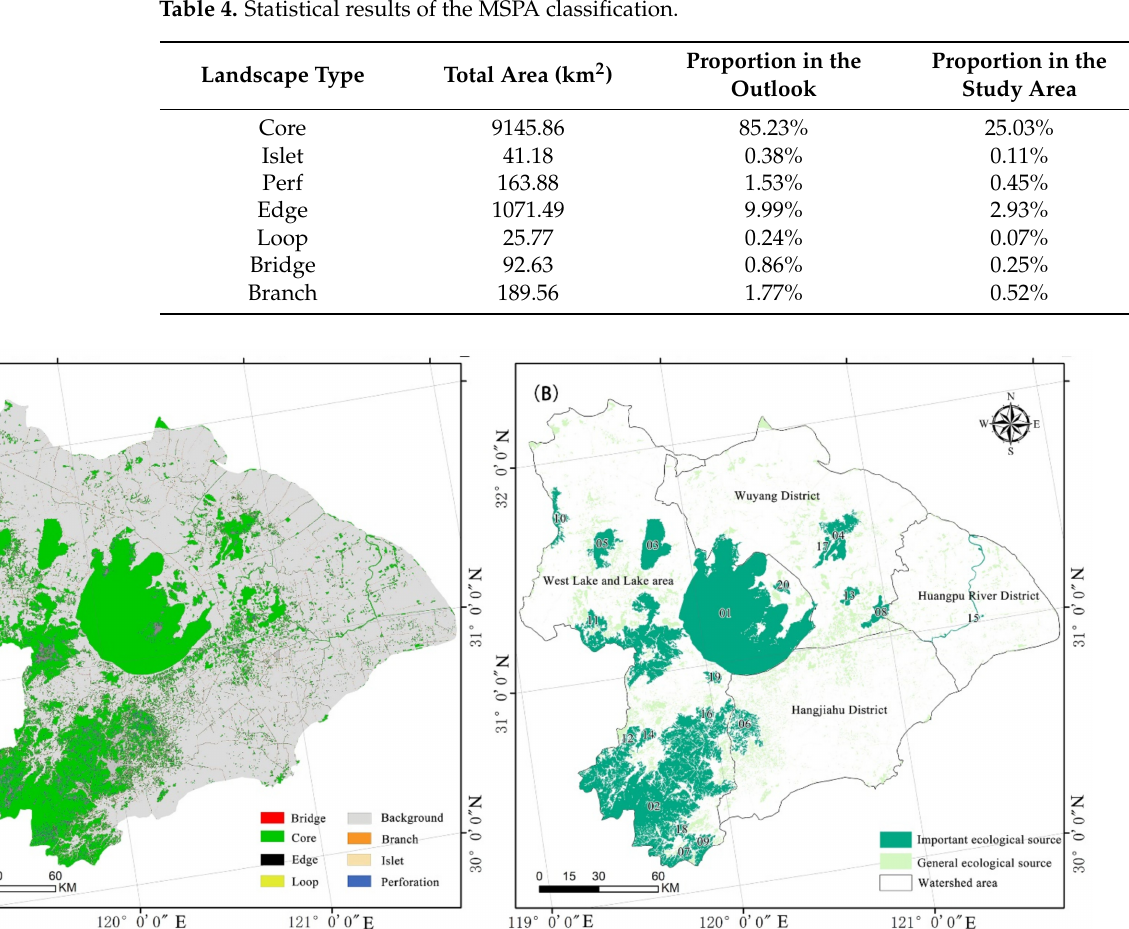
Figure 4. Important ecological sources around Taihu Lake Basin: ( A ) MSPA results; and ( B ) important ecological